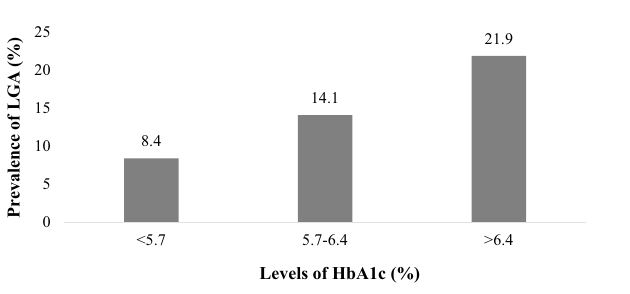
Figure 1. Prevalence of low-grade albuminuria (LGA) according to the levels of glycated hemoglobin (HbA1c).